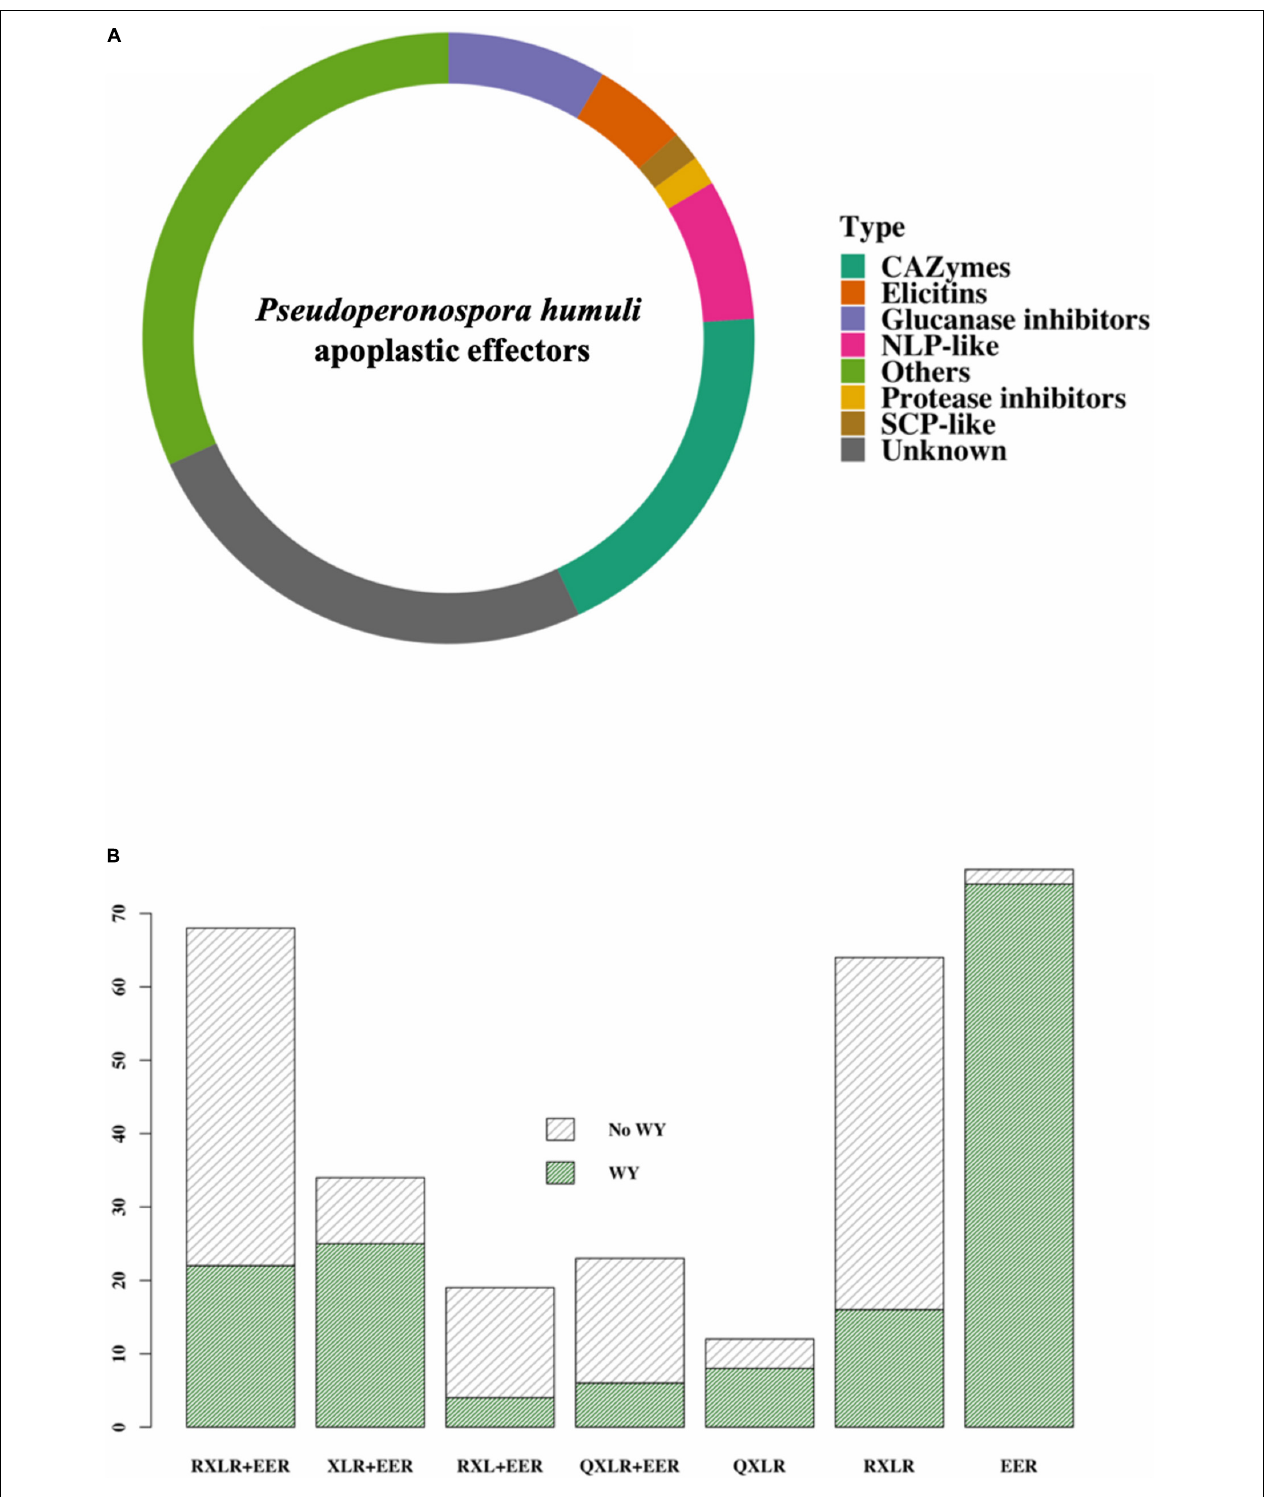
FIGURE 2 | Effectors in Pseudoperonospora humuli . (A) Classes of apoplastic effectors. Effectors were identified from the secretome by ApoplastP (Sperschneider et al., 2017) and annotated using Blast2Go and BlastP searches. Carbohydrate active enzymes (CAZymes) were identified using the dbCAN2 metaserver (Zhang et al., 2018). [SCP, sperm coat protein; NLPs, necrosis and ethylene-inducing peptide 1 (Nep1)-like proteins]. (B) Classes of cytoplasmic effectors. RXLRs were identified using the method described by Win et al. (2007) and WY motifs were predicted by a hidden markov model (HMM) search in HMMER 3.1 (hmmer.org)